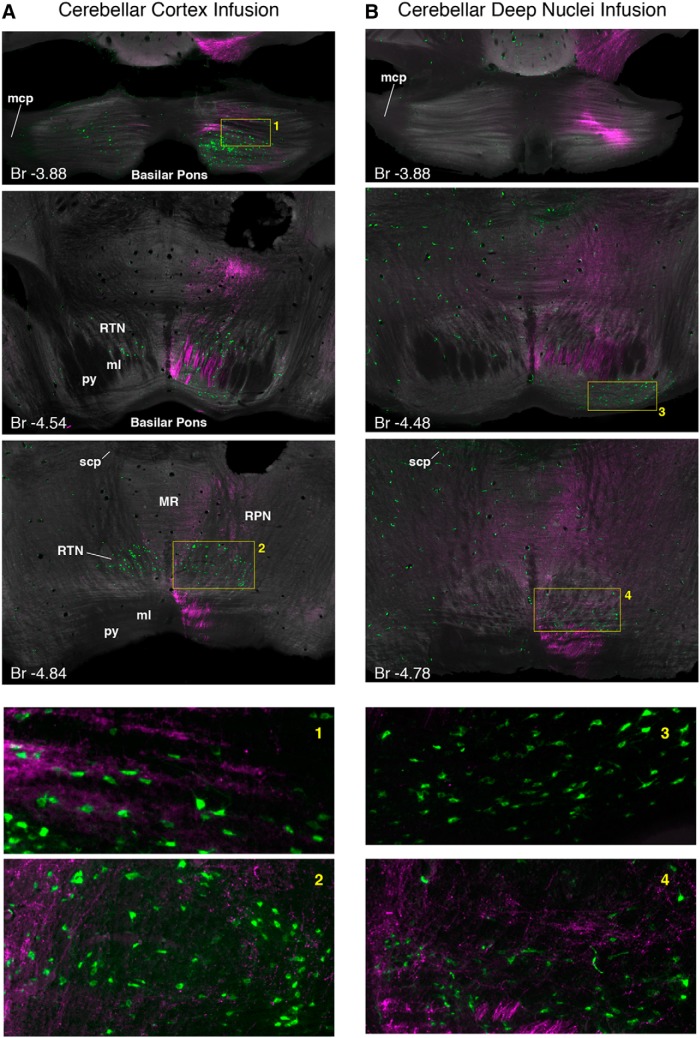
Example histology showing overlap between mPFC terminals anterogradely labeled with td Tomato and retrogradely labeled eyeblink-associated cerebellar neurons. A, Mice that received cerebellar cortex infusions showed retrogradely labeled neurons that extended throughout the anterior–posterior basilar pons (green cells, top 2 images) and into and throughout the RTN (2nd and 3rd images). Substantial overlap between mPFC terminals (magenta) and putative eyeblink-associated cells (green) was observed in the anterior basilar pons (top image, inset 1) and extensively in the RTN (2nd and 3rd images, inset 2). B, Mice that received deep nuclei infusions showed retrogradely labeled neurons (green cells) restricted to the caudal basilar pons (2nd image) and less dense labeling in the more anterior RTN (3rd image). Few if any mPFC terminals were observed in the caudal basilar pons and did not appear to overlap substantially with the labeled pontocerebellar neurons observed there (2nd image, notice the general absence of magenta terminal labeling in inset 3). Overlap was observed the RTN (3rd image, inset 4). Br, Bregma; mcp, middle cerebellar peduncle; ml, medial lemniscus; py, pyramidal tract; scp, superior cerebellar peduncle; MR, median raphe nucleus; RPN, reticular nucleus of the pons.